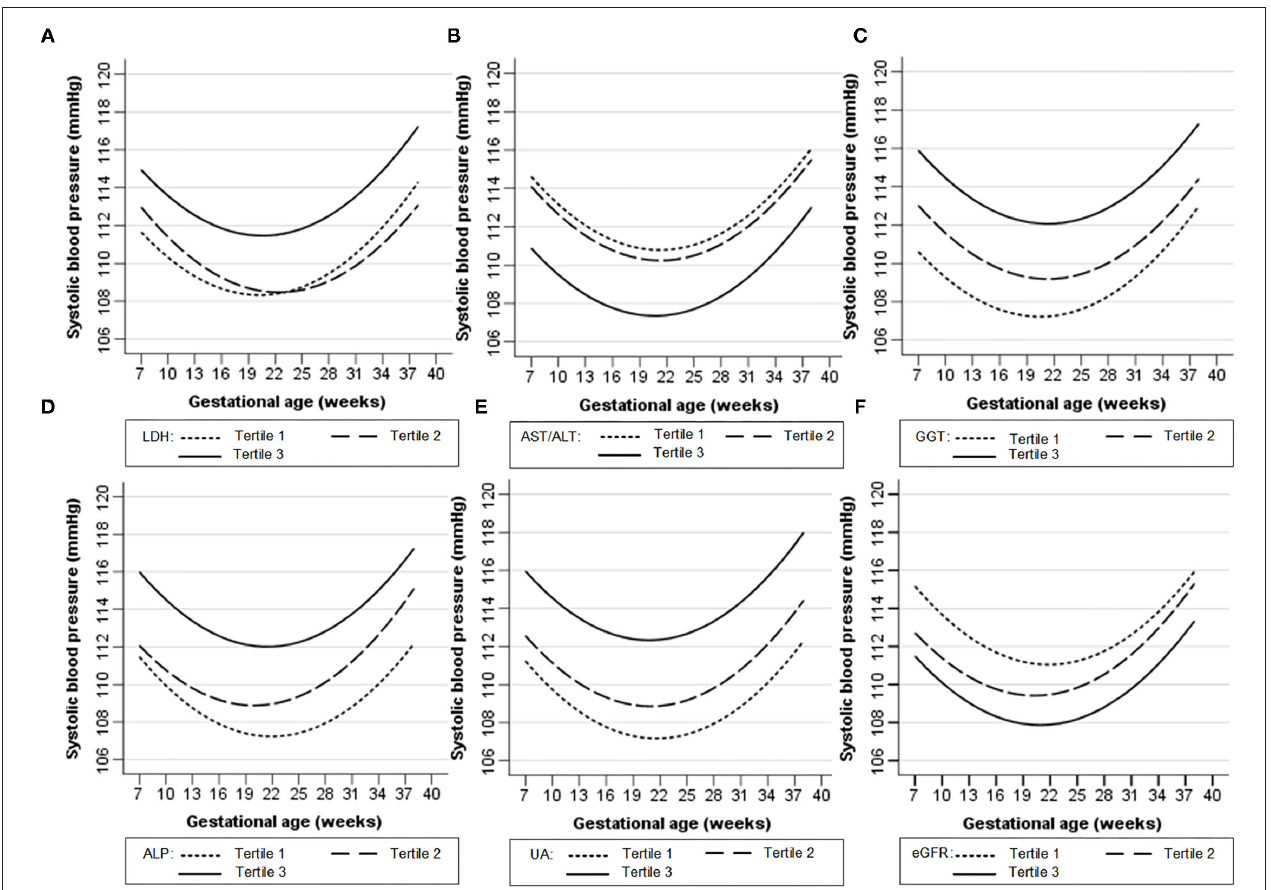
FIGURE 1 | Longitudinal trend of systolic blood pressure change with gestational age vs. early-pregnancy biomarkers levels, predicted by linear mixed-effects regression models. (A) lactate dehydrogenase (LDH); (B) aspartate aminotransferase to alanine aminotransferase ratio (AST/ALT); (C) gamma-glutamyl transpeptidase (GGT); (D) alkaline phosphatase (ALP); (E) uric acid (UA); (F) estimated glomerular filtration rate (eGFR).